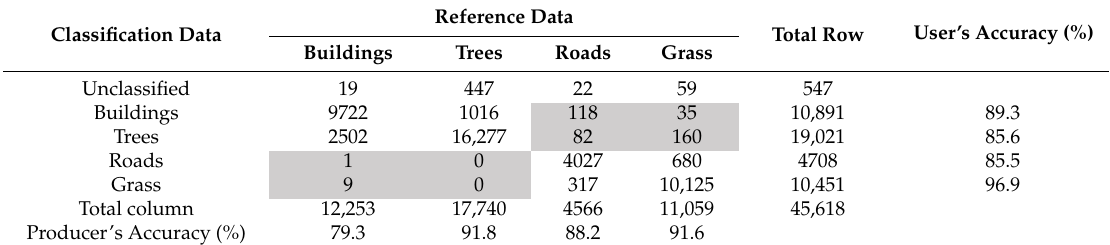
Table 8. Confusion matrix for point classification based on NDVI MIR-G